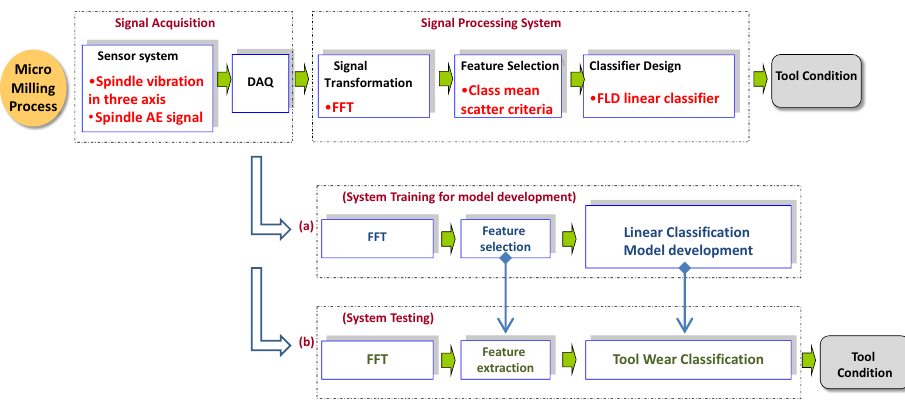
Figure 4. Schematic of tool wear monitoring system for tool wear classification.